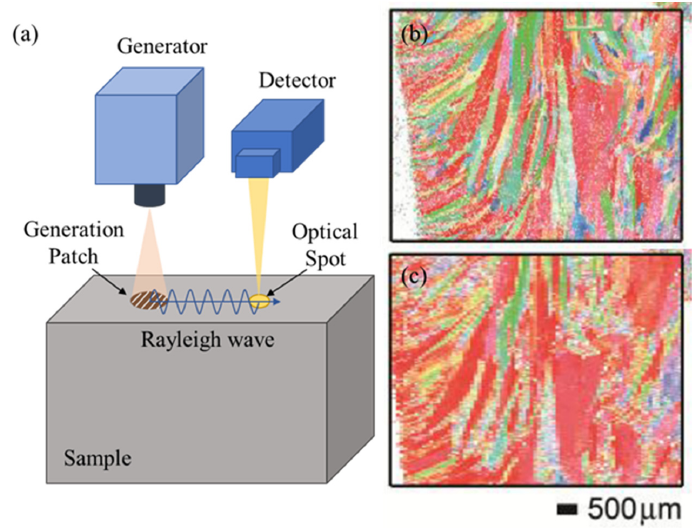
Figure 9. ( a ) Schematic showing the optical and acoustic working principles for the SRAS technique, ( b ) the SRAS imaging of the grain distribution of a weld specimen, ( c ) the EBSD reconstruction for the weld specimen [113] .